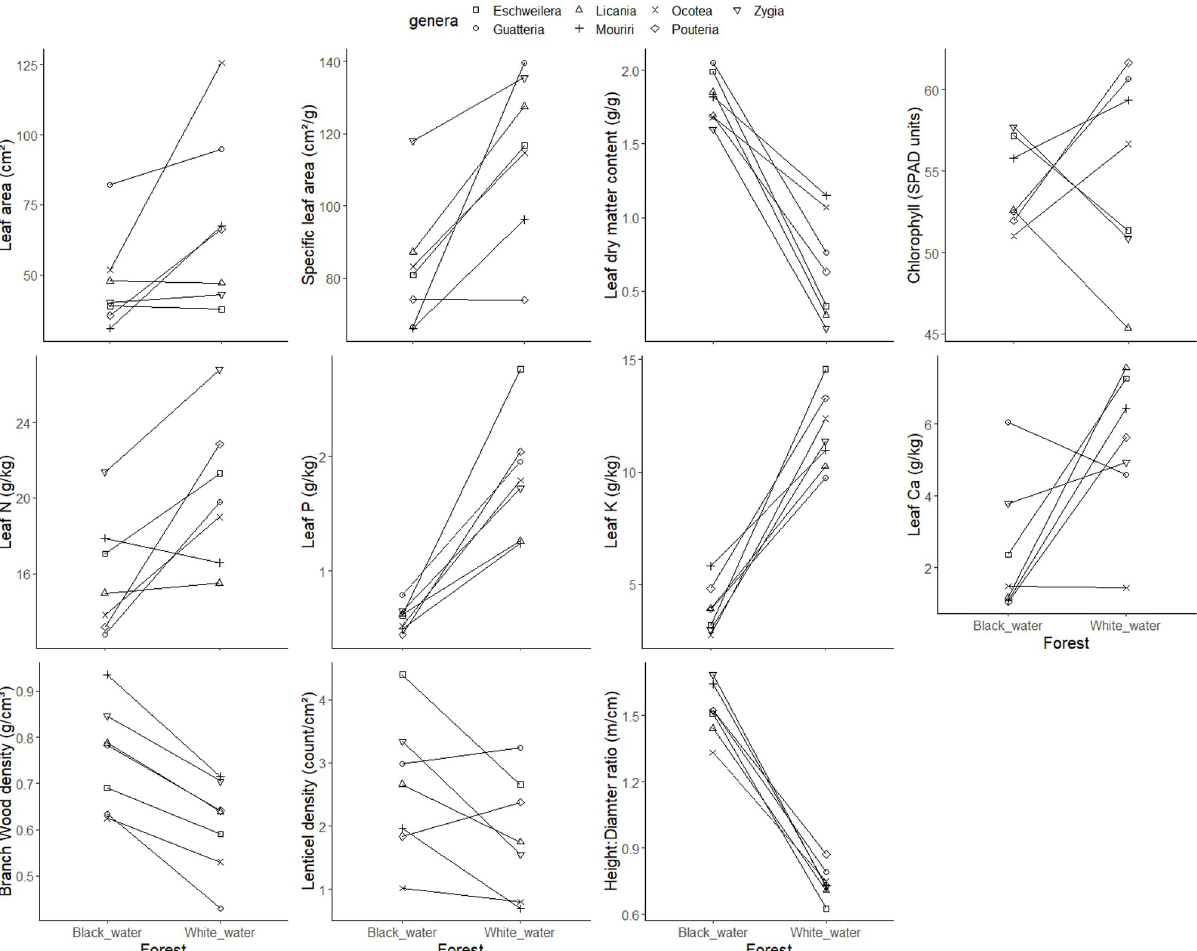
Fig 1. Mean values of leaf area, specific leaf area, leaf dry matter content, leaf chlorophyll, leaf nitrogen (N), leaf phosphorus (P), leaf potassium (K), leaf calcium (Ca), branch-wood density, lenticel density and height:diameter ratio for seven pairs of congeneric species of white-water and black-water forests. Lines connect the congeneric pairs. Mean values were based on 5 individuals per genus and forest type.